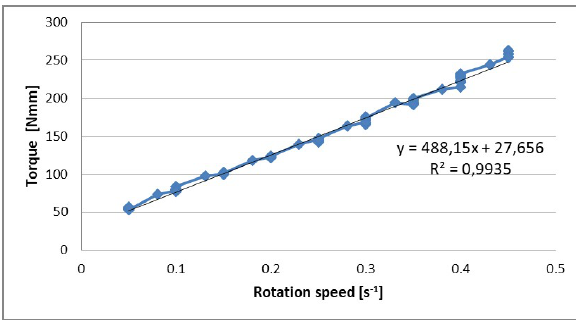
Figure 7: Down-curve and the linear approximation measured after 10 min. (12 mm Fib1, dosage 0.6 kg per 1 m 3 ).